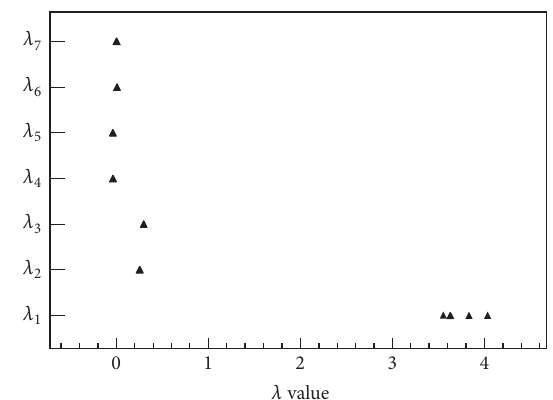
Figure 2: The values of 𝜆 parameters which result in Higgs boson masses shown in Figure